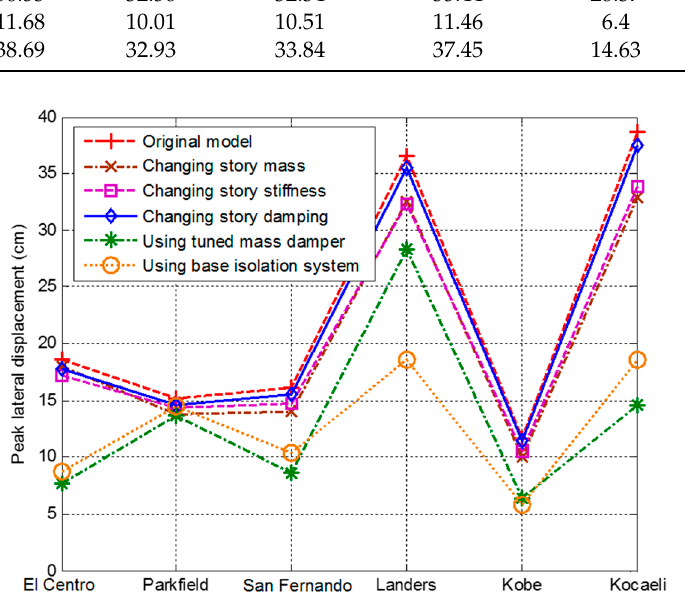
Figure 11. Peak relative displacement for the top story of building for different cases.